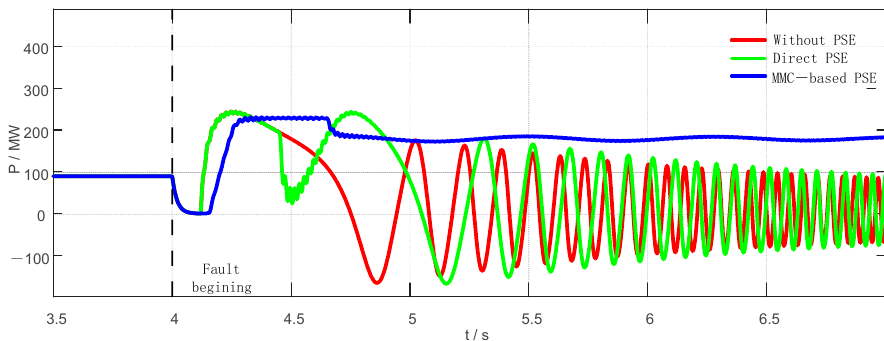
Figure 16. Power of the double-circuit transmission line.